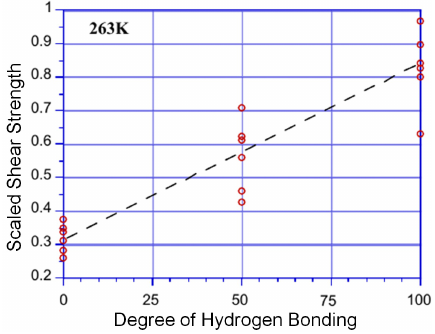
Figure 5. Scaled shear strength as a function of degree of hydrogen-bonding for different self assembled monolayers. Reprinted with permission from Ref.